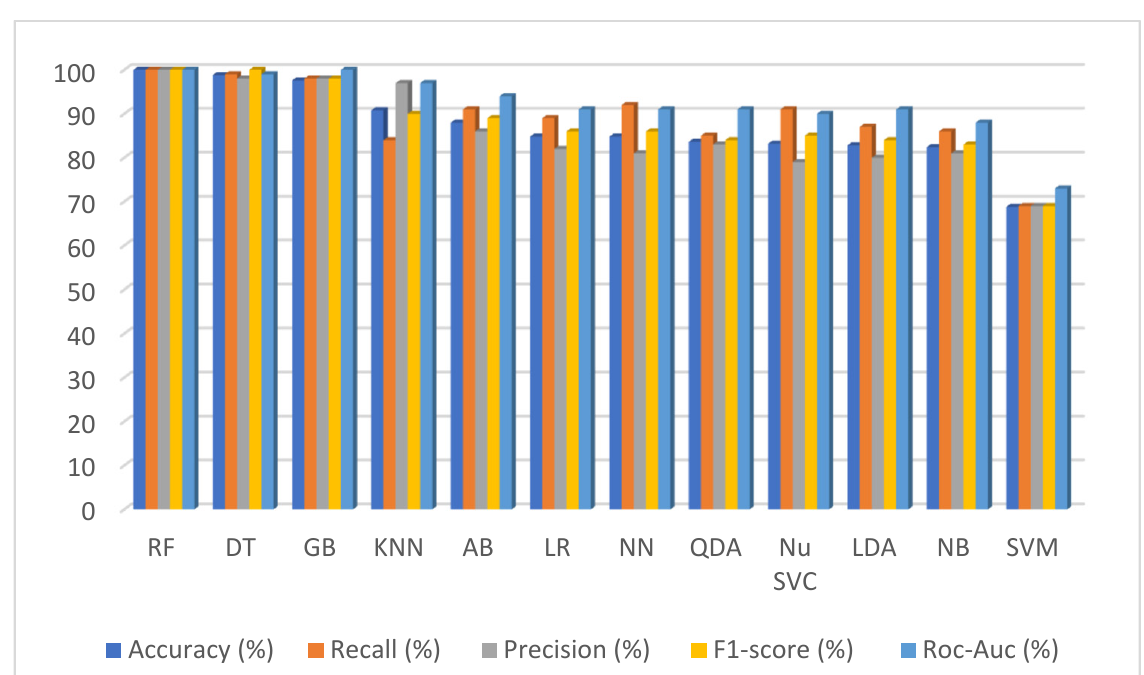
Figure 13. Results of different machine learning models. Table 2. Results of different machine learning models.